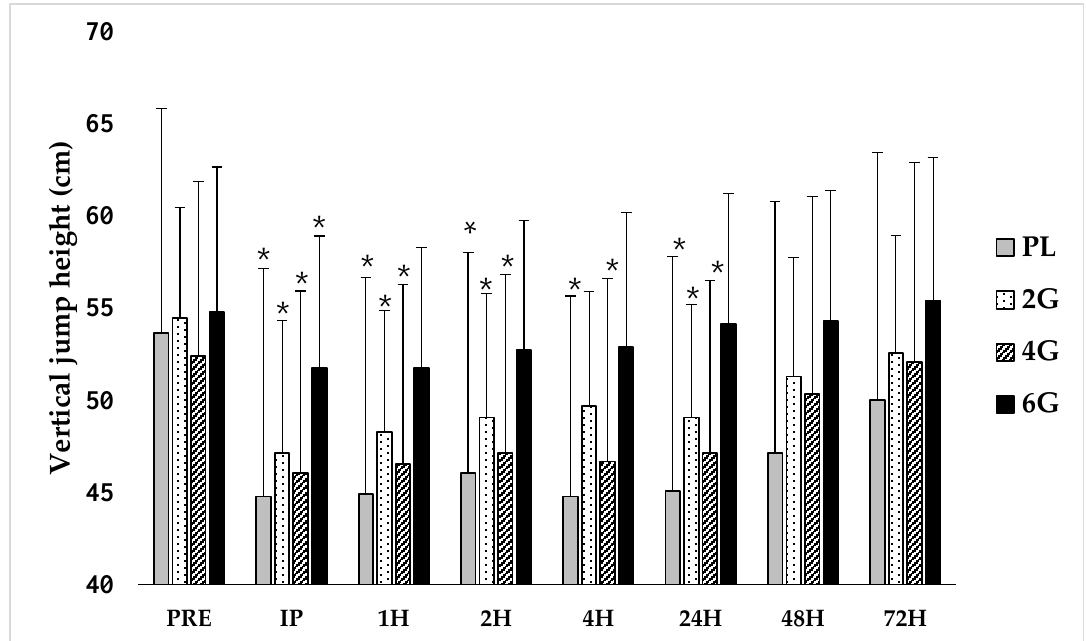
Figure 2. Effect of fish oil supplementation dosing on the recovery of vertical jump height following a bout of muscle-damaging exercise. (n = 32; n = 8 per group; data are presented as mean ± standard deviation) . * indicates statistical significance ( p < 0.05) from PRE for a given fish oil dose; PRE = pre-exercise; IP = immediate post-exercise; H = hour post-exercise; PL = placebo; G = grams per day; cm = centimeters.